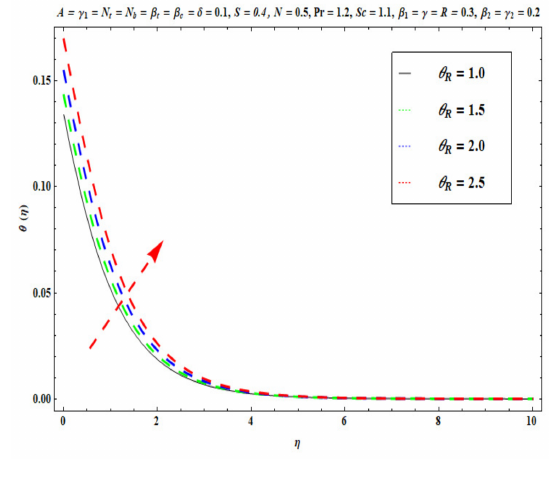
Figure 13. Against θ R .